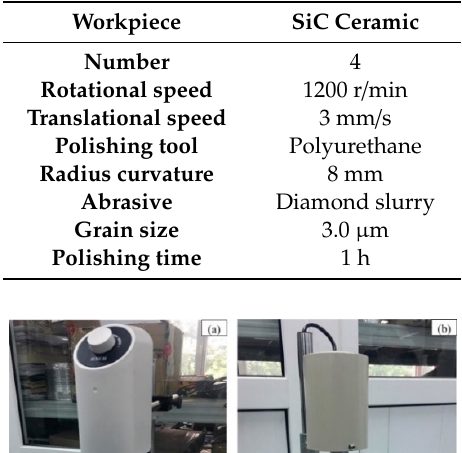
Table 3. Micropolishing Experiment condition.